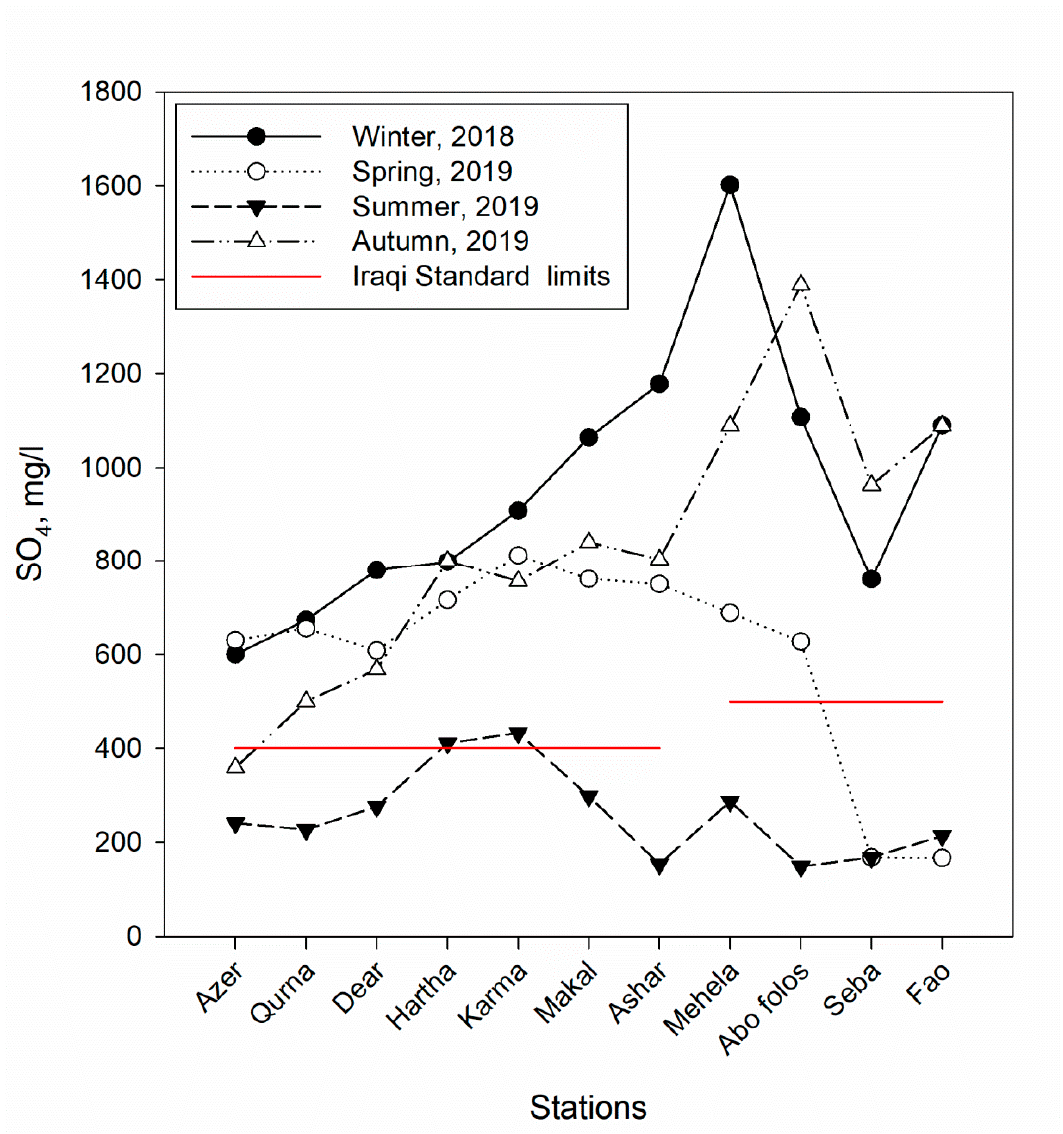
Figure 8. The sulfate (SO 42 − ) concentrations of the selected stations for different seasons during the study period.